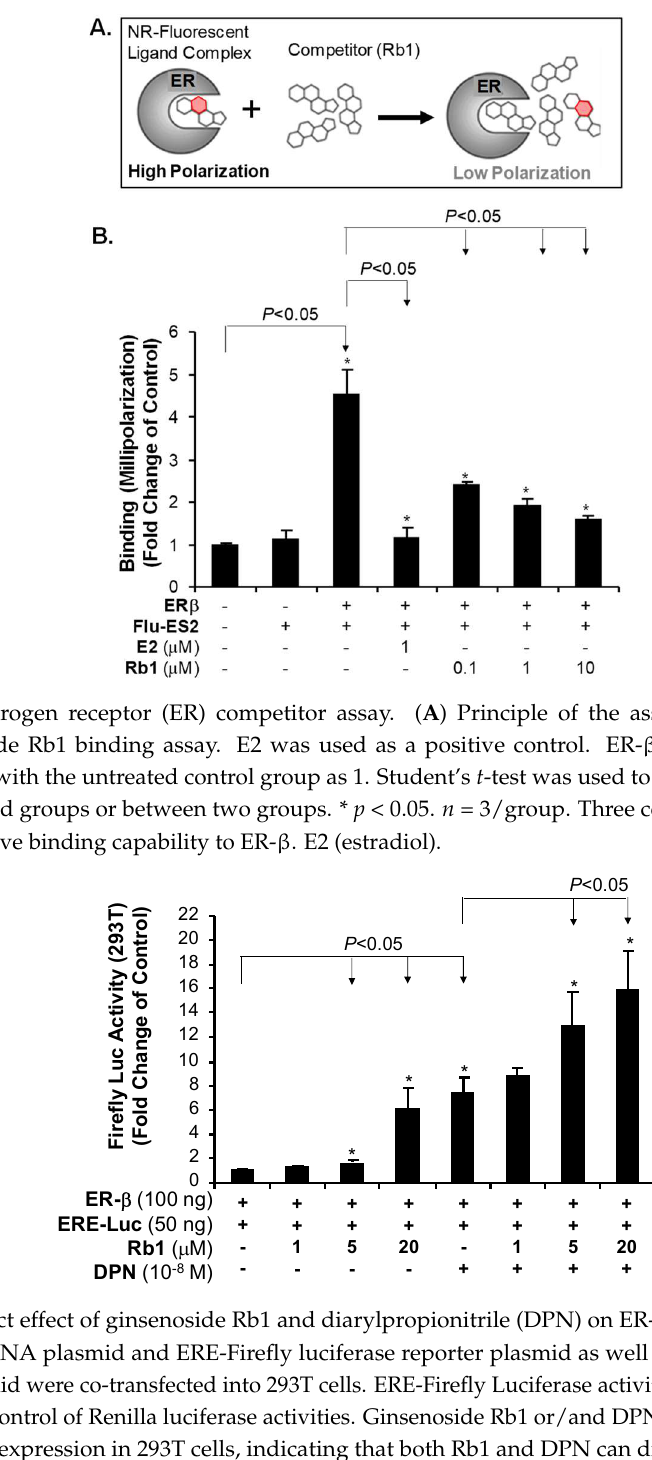
Figure 8. Direct effect of ginsenoside Rb1 and diarylpropionitrile (DPN) on ER-β activation in 293T cells. ER-β cDNA plasmid and ERE-Firefly luciferase reporter plasmid as well as Renilla luciferase reporter plasmid were co-transfected into 293T cells. ERE-Firefly Luciferase activities were